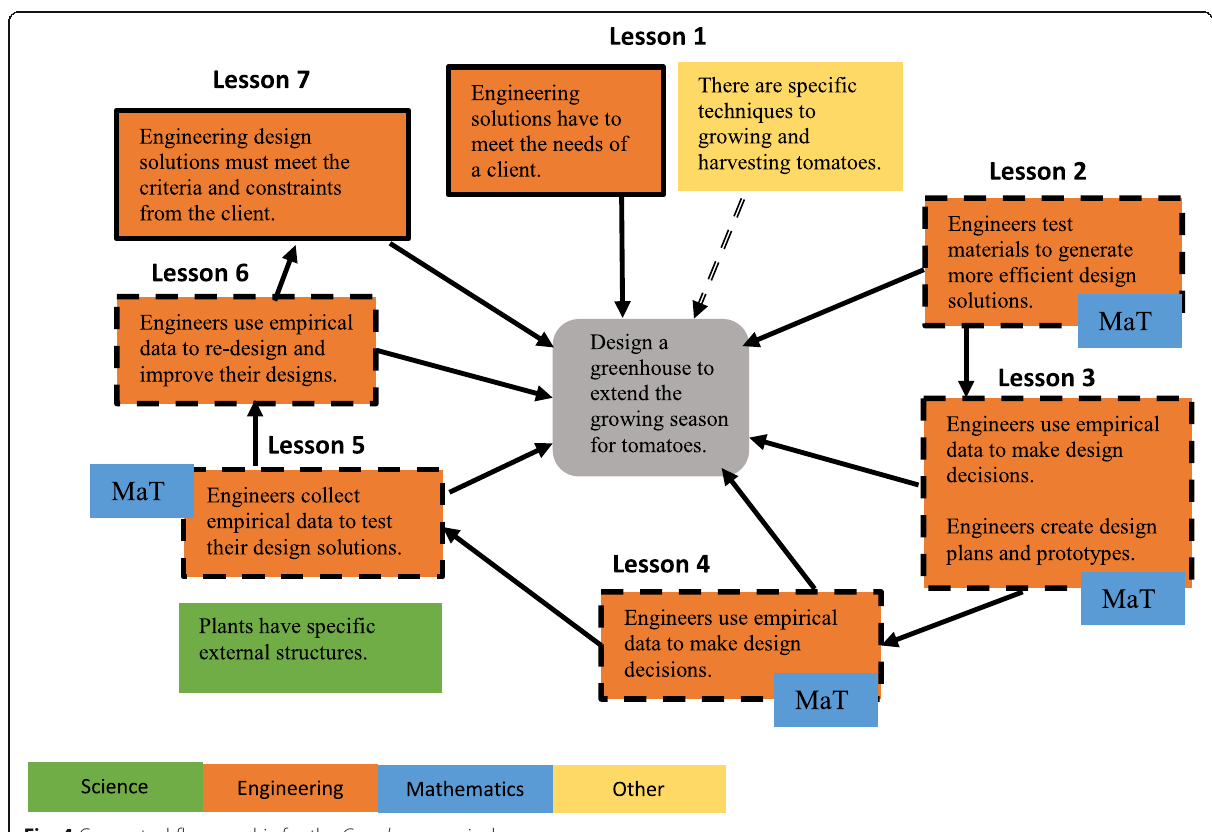
Fig. 4 Conceptual flow graphic for the Greenhouse